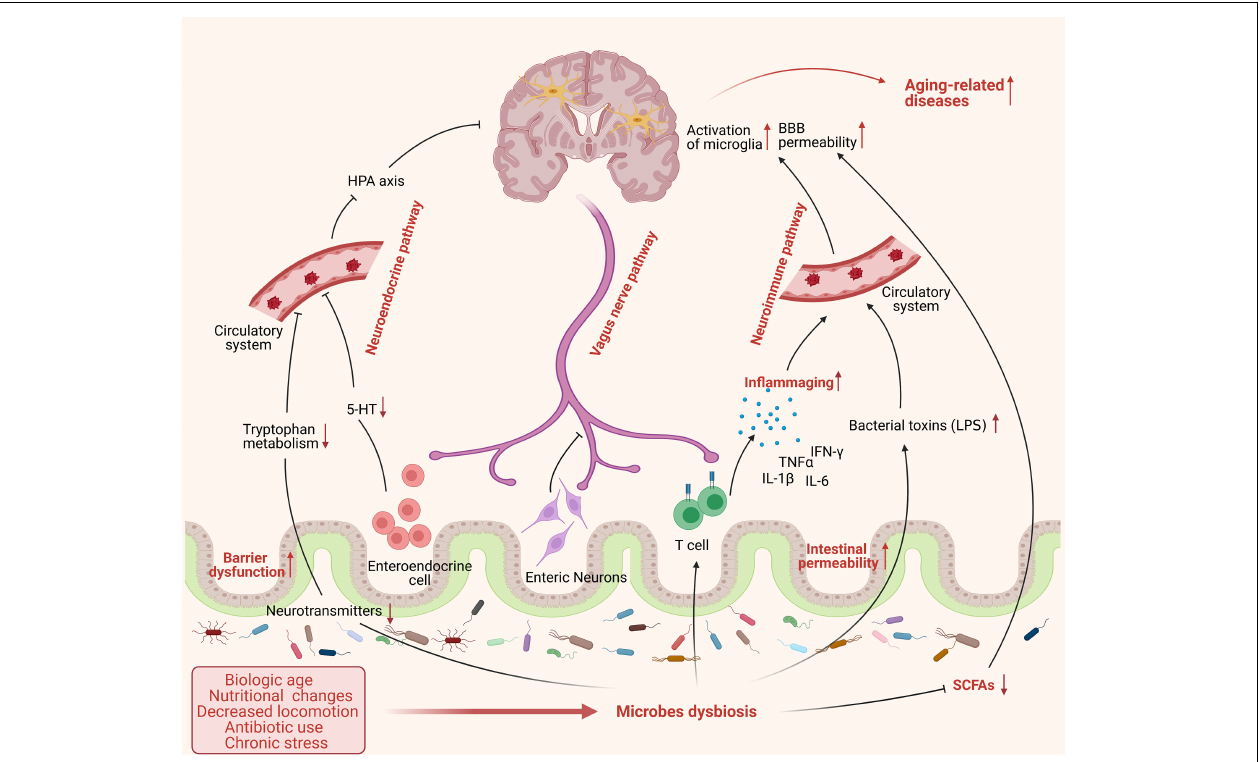
FIGURE 2 | The dysbiosis of gut microbes in aging process. Aging is accompanied by significant changes in lifestyle, such as biological age, nutritional changes, decreased locomotion, antibiotic use, and chronic stress, which may cause an alteration of microbes’ composition and exacerbate the dysbiosis of gut microbiota in frail elderly people. Microbes dysbiosis in aging shows a severe decrease of beneficial bacteria, such as SCFA-producing bacteria, and increased pathogenic bacteria, such as Enterobacteriaceae, affecting gut physiology and leading to reduced intestinal motility, gut-barrier dysfunction, and increased intestinal permeability. Furthermore, the dysbiosis of microbiota could influence the brain function through various routes including: (1) promote the release of pro-inflammatory cytokines and bacterial toxins to the circulatory system, such as LPS, causing systemic inflammation via neuroimmune pathway; (2) inhibit the transmission of neural signal from enteric nervous system (ENS) to central nervous system (CNS) mainly via vagus nerve; (3) suppress the production and release of microbial neurotransmitters and hormones to circulatory system and subsequently to brain through neuroendocrine pathway. All these factors cause a chain of detrimental events to the brain that enhancing the risk of developing aging-related pathologies. (This figure was created with